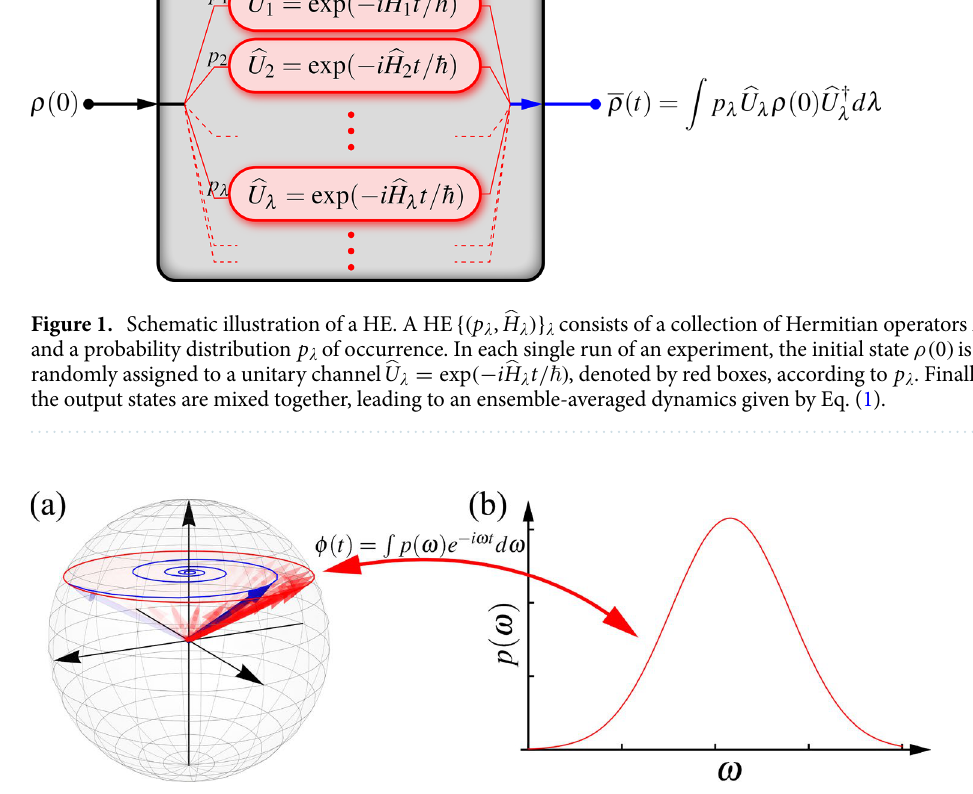
Figure 2. ( a ) Random phase model of qubit pure dephasing. The ensemble of red arrows denotes the random σ z / 2 . The opacity reflects that each of the unitary operators unitary rotations generated by (cid:31) ω ˆ by the probability distribution p (ω) . The ensemble-averaged state, denoted by the blue arrow, then undergoes a pure dephasing dynamics. ( b ) The probability distribution function p (ω) fully determines the pure dephasing dynamics via the Fourier transform; consequently, it is promoted to a representation of qubit pure dephasing in frequency